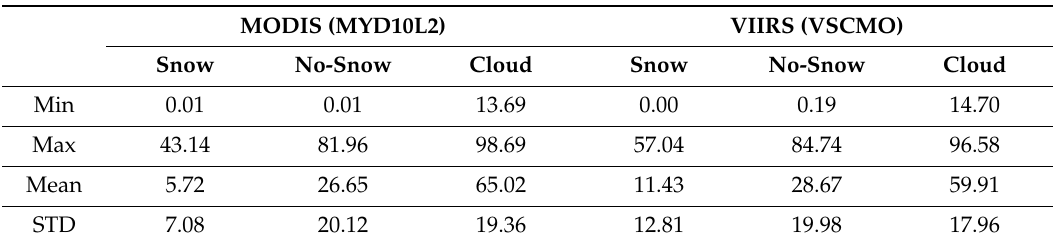
Table 2. Percentage of total snow, no-snow and cloud fractions of the MODIS and VIIRS daily swath snow products in the study area during the 2016 hydrological